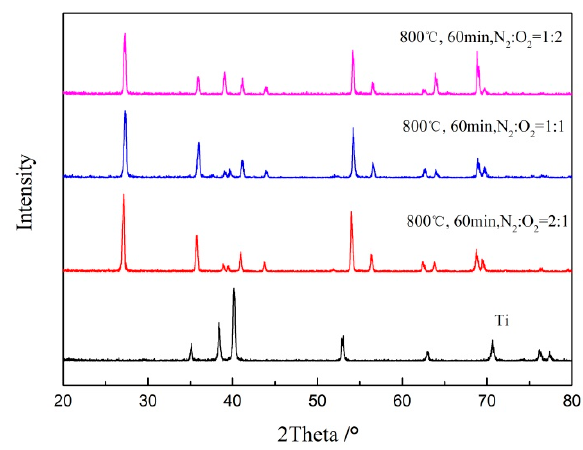
Figure 5. XRD pattern of Ti support after oxidation at 800 °C for 60 min, at different oxygen concentrations.